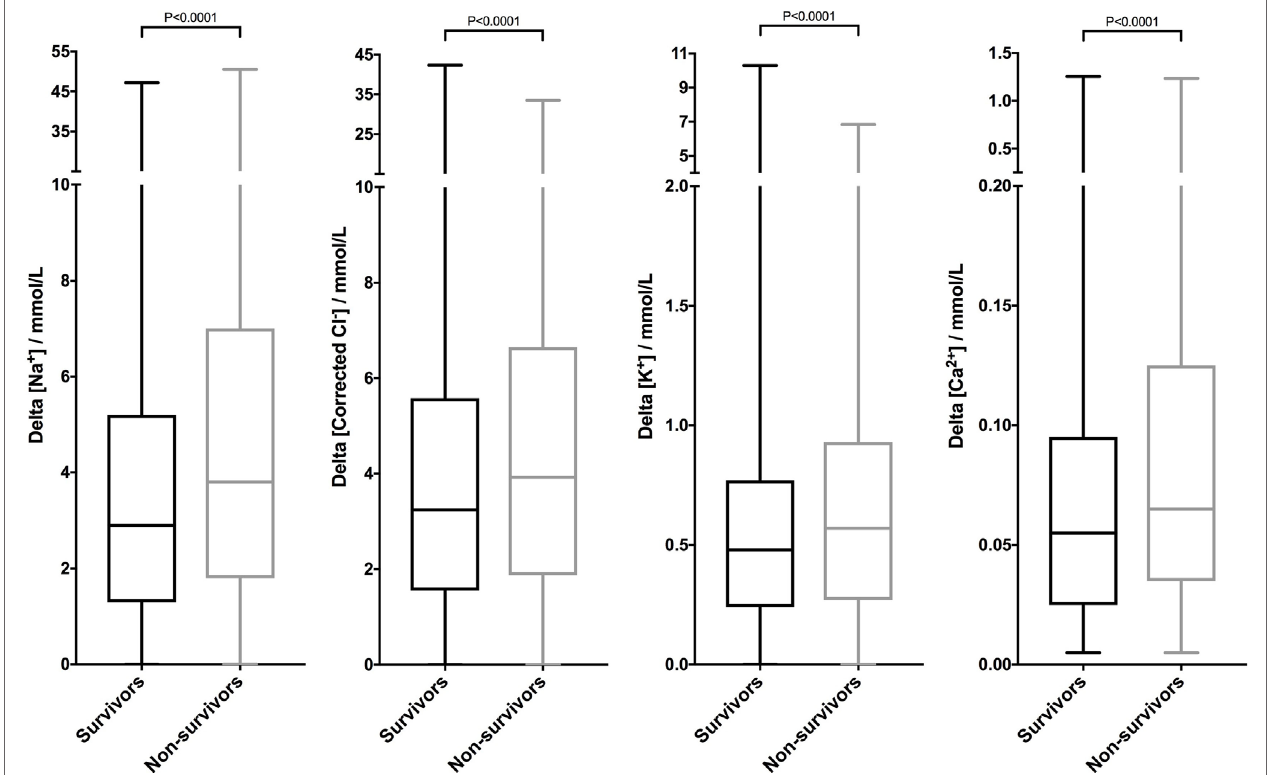
FigUre 5 | Canine electrolyte values are significantly different between survivors and non-survivors. Box and whisker plots of the deviations between patient sodium, corrected chloride, potassium, and ionized calcium values from the midpoints of their reference intervals were constructed from a database of 33,117 canine samples. The delta electrolyte concentrations were plotted according to outcome. Patients that died or were euthanized were classified as non-survivors. Patients that were discharged alive were classified as survivors. The delta electrolyte values for all four electrolytes were significantly larger for non-survivors compared to survivors (all P < 0.0001 by Mann–Whitney U test).